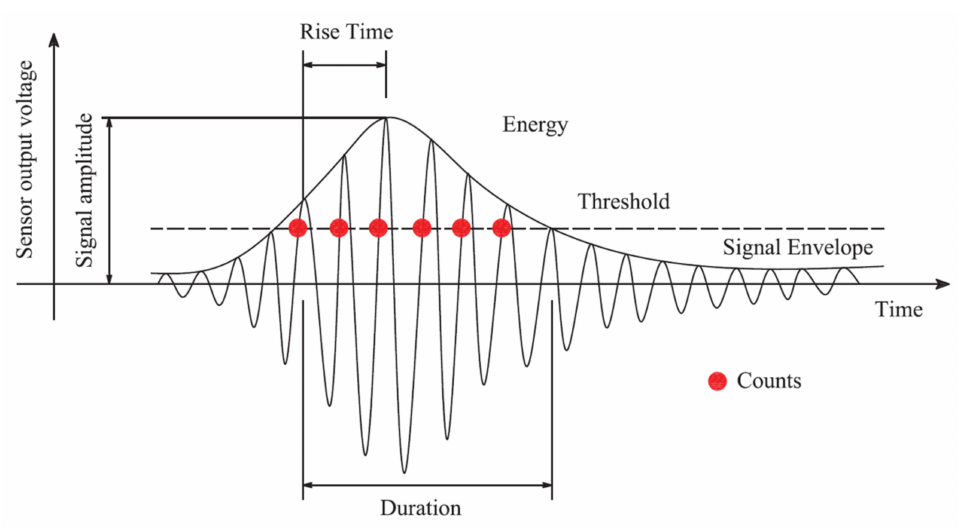
Figure 1. Basic parameters of acoustic emission AE.